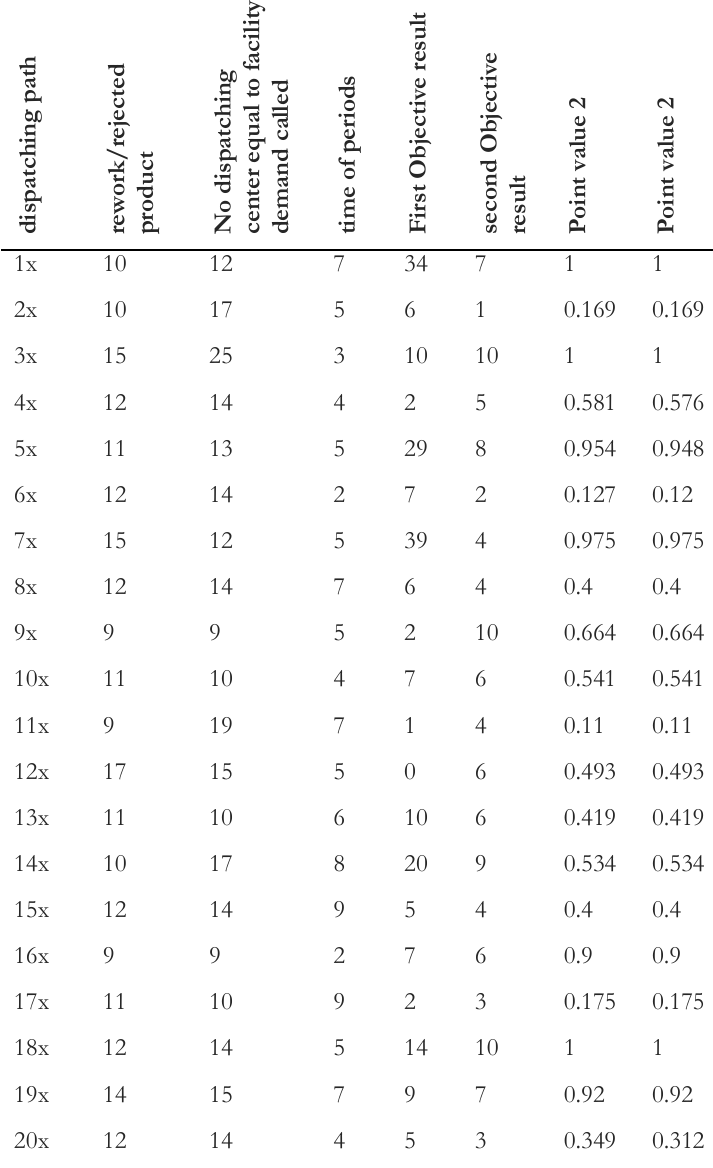
Table 17. The final value of dispatching system corresponding to facility and dispatching